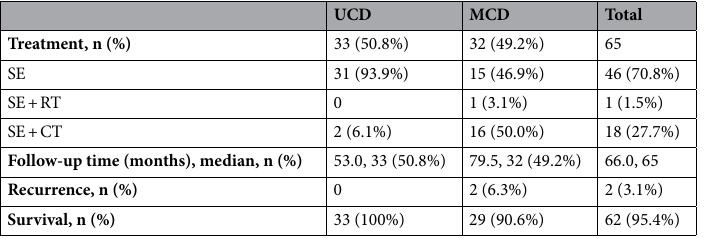
Table 1. Treatment choices and treatment outcomes. SE surgical excision, RT radiotherapy, CT